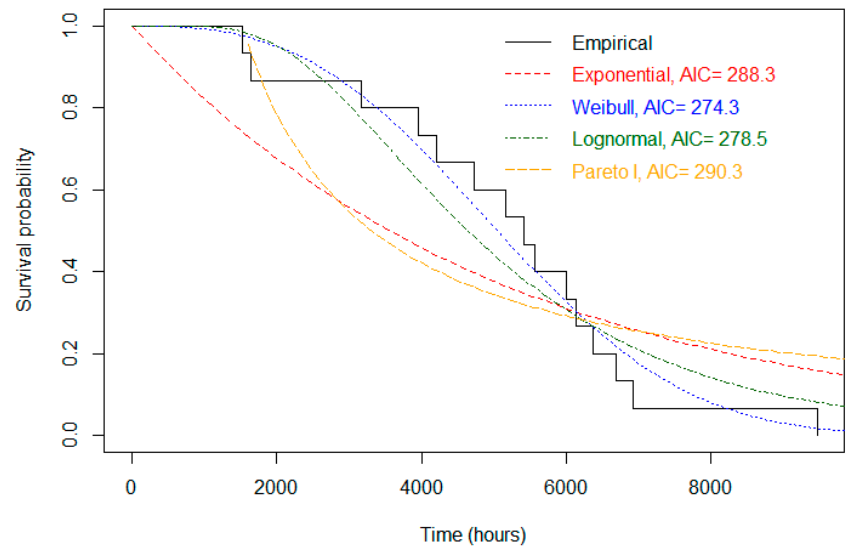
Figure 8. Empirical survival function and fitted parametric survival functions based on a dataset consisting of failure times (in hours) of transmission on n = 15 caterpillar